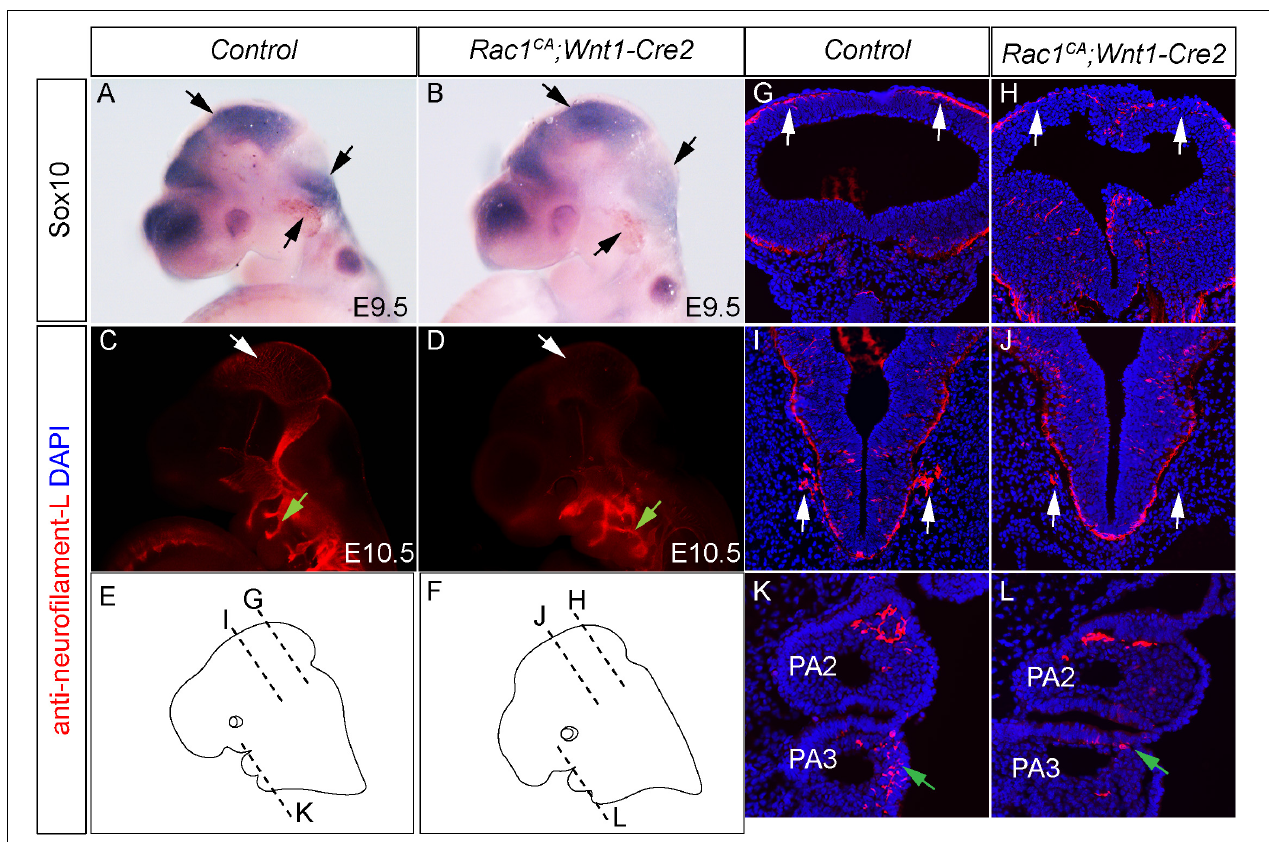
FIGURE 6 | Augmented Rac1 activity alters neural crest cell migration in vivo . (A,B) Whole-mount in situ hybridization with Sox10 antisense mRNA probe in E10.5 littermate control (A) and Rac1 CA ;Wnt1-Cre2 (B) embryos. Arrows point to counterparts in both embryos, where Sox10 expression is altered in the mutant. (C,D) Whole-mount immunostaining using anti-neurofilament L antibody of E10.5 littermate control (C) and Rac1 CA ;Wnt1-Cre2 (D) embryos. Blank arrows point to midbrain. Green arrows point to neurofilament in pharyngeal arch (PA) 2. (E,F) Diagram shows section levels in C,D , as illustrated in G–L . (G–L) Coronal sections of C,D at comparable levels illustrated in E,F . Blank arrows in H,J point to reduced neurofilament L expression in the mutant compared to that in G,I , respectively. Green arrow in L points to misguided NCCs expressing neurofilament in mutant PA3 when compared to the counterpart tissues in the control PA3 shown in K